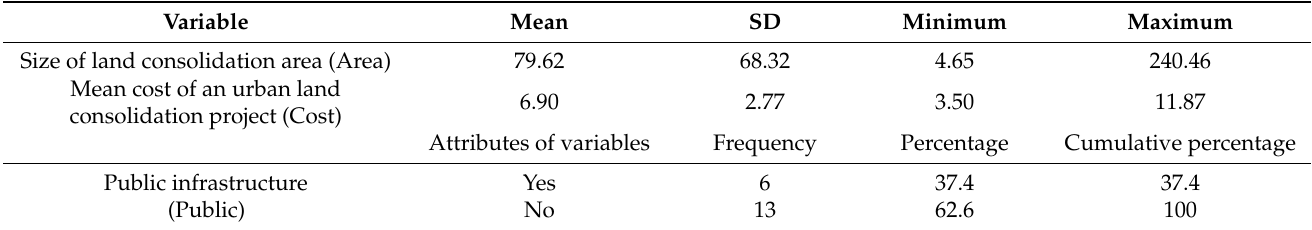
Table 3. Descriptive statistics of the Level 2 independent